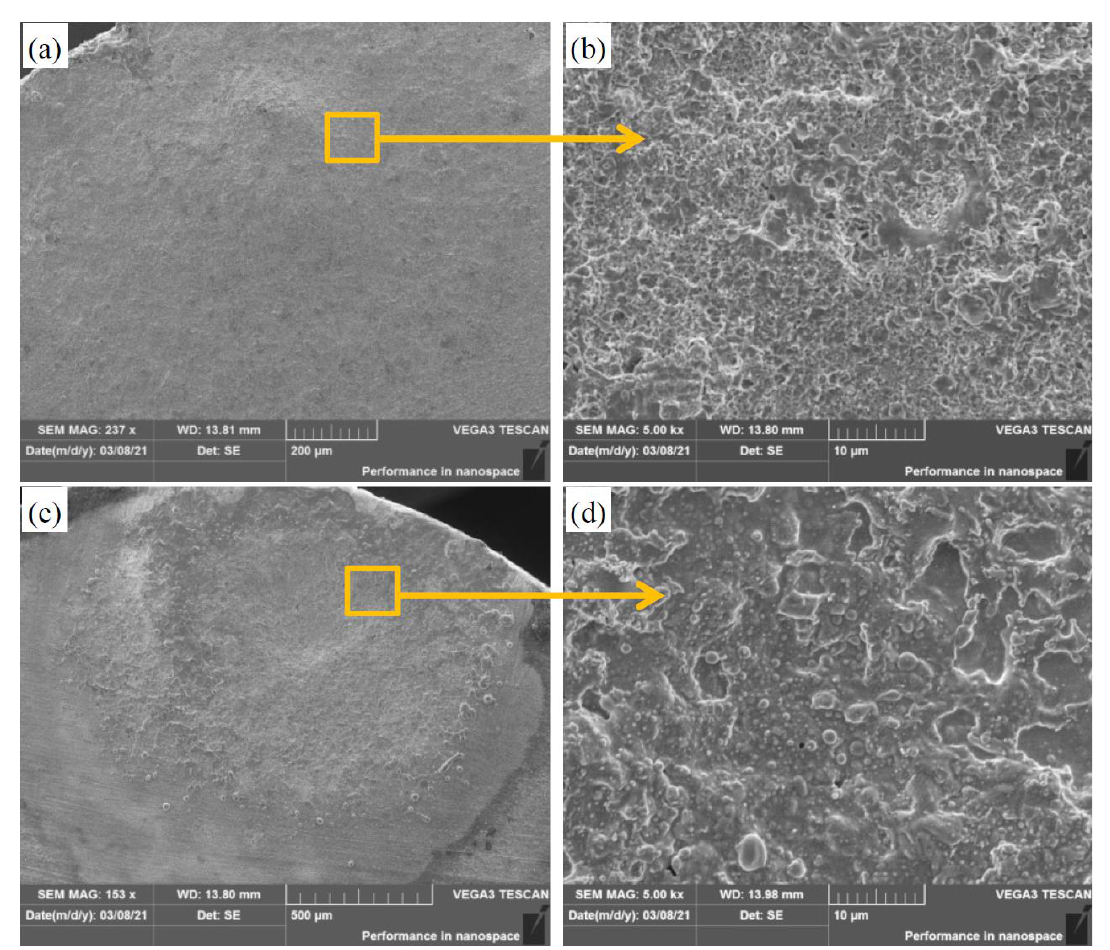
Figure 14. Surface observation of Cu-20 wt% W composite contacts after electrical contact test: ( a ) anode contact; ( b ) enlarged view of ( a ); ( c ) cathode contact; ( d ) enlarged view of ( c ).